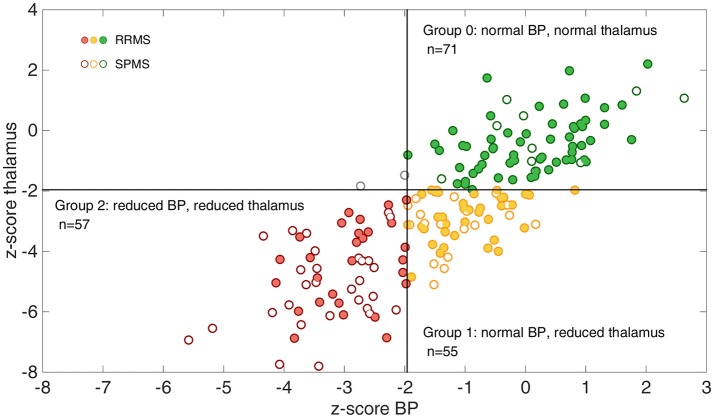
Illustration of the grouping of the whole MS patient cohort according to thalamic and whole brain atrophy. The association between z-scores for brain parenchyma (BP) and z-scores for thalamus volumes are shown. Using a cut-off of −1.96 almost all patients (except for two) fall into one of the three groups: group 0 = no atrophy (green circle, upper right quadrant), group 1 = thalamic atrophy without BP atrophy (yellow circle, lower right quadrant) and group 2 = thalamic and BP atrophy (red circle, lower left quadrant). Relapsing-remitting MS (RRMS) patients are marked with a filled circle in all groups, while secondary-progressive MS (SPMS) patients are marked with open circles.